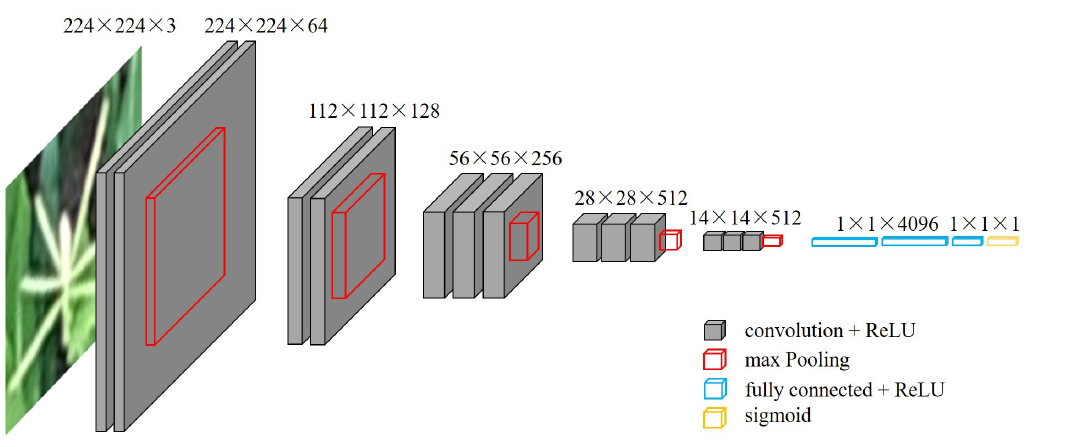
Figure 8. Architecture of VGG16 network.